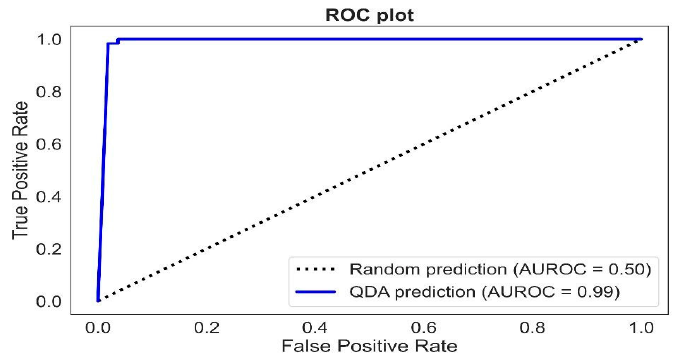
Figure 9. ROC plot for the quadratic discriminant analysis classification model, which produced the best-performing model on all scores for the stress incidence threshold of 6%.